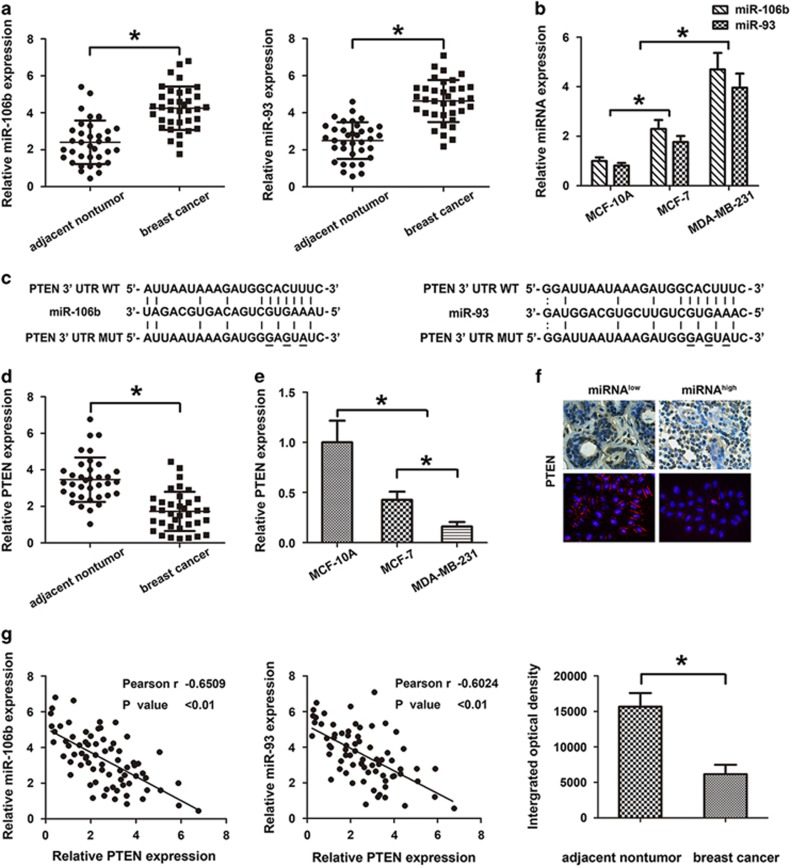
The inverse relationship between the levels of the two miRNAs (miR-106b and miR-93) and PTEN. (a) The relative level of the two miRNAs in breast cancer tissues and matched adjacent nontumor tissues. (b) The expression of the two miRNAs in the cell level (MCF-10A, MCF-7 and MDA-MB-231). (c) The results of the software (TargetScan Human 7.1 and microRNA.org.) (d) The relative PTEN expression in the tissue level (breast cancer tissues and adjacent nontumor tissues). (e) The relative PTEN expression in the cell level (MCF-10A, MCF-7 and MDA-MB-231). (f) In the tissues and cells (adjacent nontumor tissues or MCF-7 cells) with a lower expression of the two miRNAs, PTEN level was obviously higher than that in tissues and cells (breast cancer tissues or MDA-MB-231 cells) with higher expressed miRNAs. (g) The inverse relationship between the two miRNAs and PTEN. Each experiment was independently performed at least three times. Data were presented as mean±S.D. (*P<0.05)